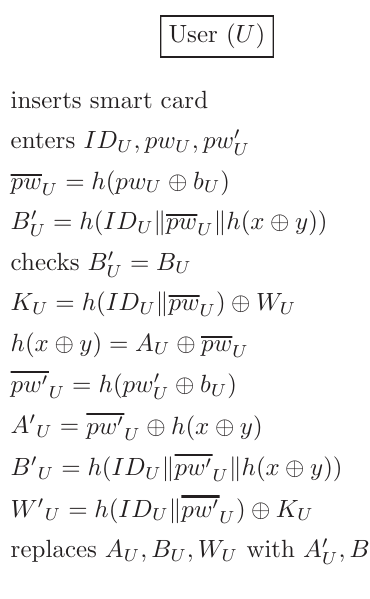
Figure 9. The password update phase.